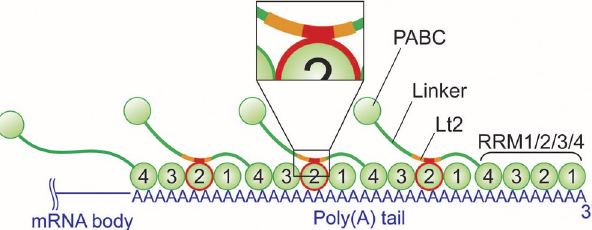
Figure 8. Schematic representation of the repeating nature of the PABPC1 multimer on poly(A). PABPC1 molecules on poly(A) are multimerized by interaction between the RRM2 of one molecule and the Lt2 region containing a portion containing residues 428–442 in linker of the neighbouring molecule. Linker was drawn as a green line. The Lt2 region and the residues 428–442 were colored orange and red, respectively. It should be noted that RRM1/2/3/4 covering poly(A) is illustrated in a linear fashion, as the structure of RRMs 3 and 4 in the poly(A)-bound state remains